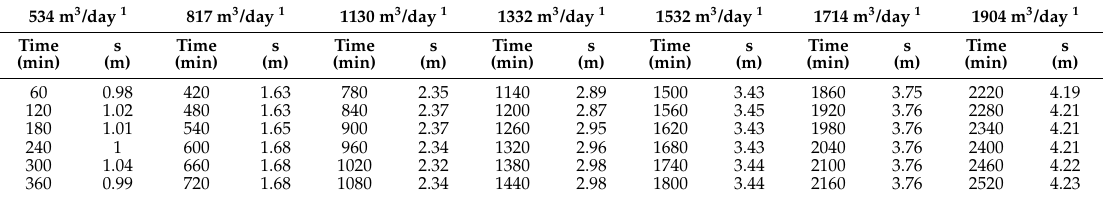
Table 1. Field measurements derived from the step-drawdown